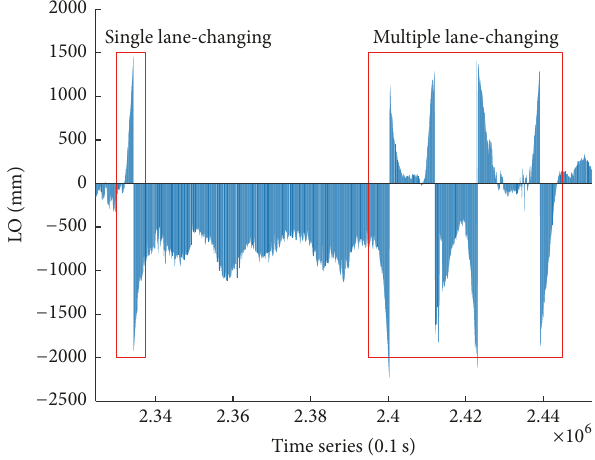
Figure 4: An example of LO values in the